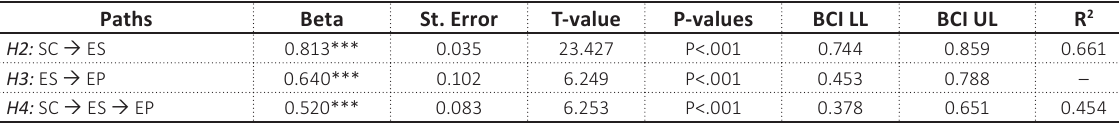
Table 7. Structural path analysis: the mediation effect of entrepreneurial skills Paths Beta